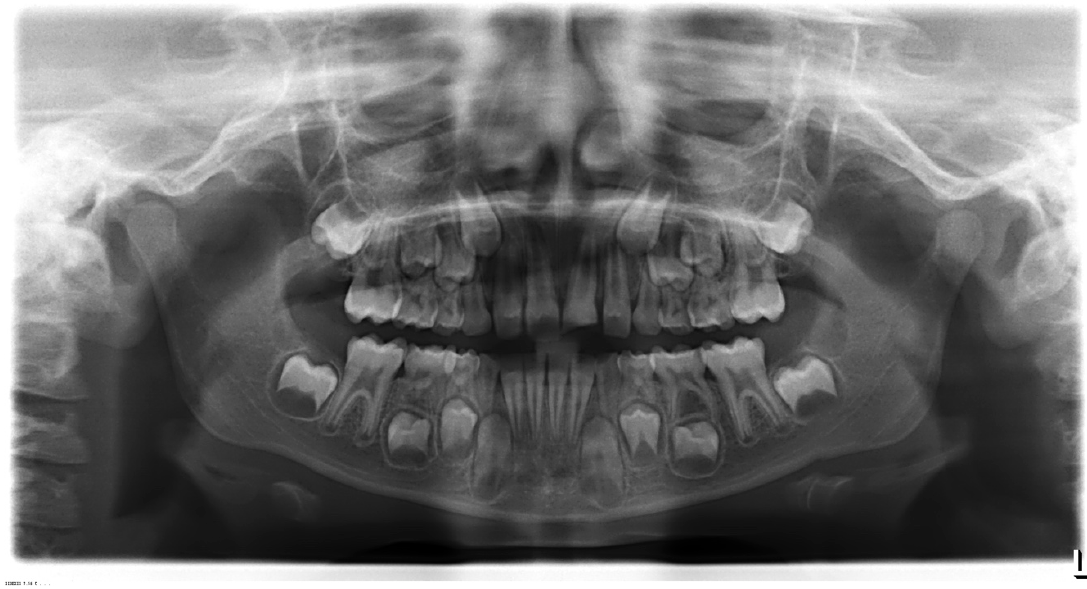
Figure 2. Preoperative orthopantomography.